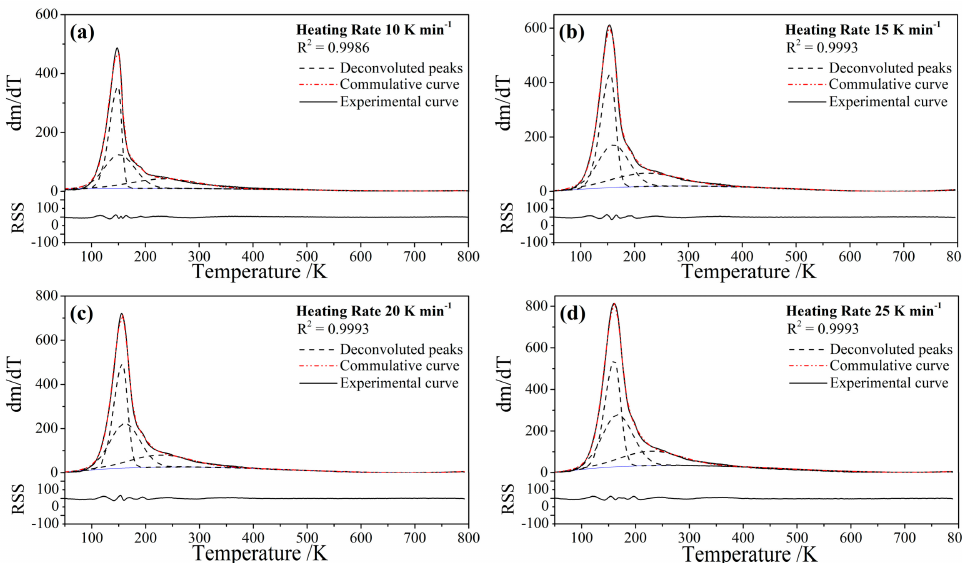
Figure 5. Four deconvoluted DTG peaks were observed from overlapped DTG peaks from modified co-mathematical functions for the experimentally observed DTG curve of the studied thermal solid- state